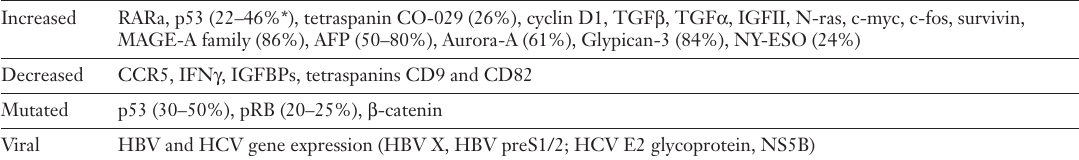
Table 1 Gene Expression Changes in HCC.